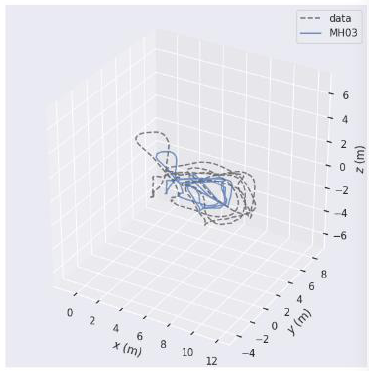
Figure 5. Trajectory of visual SLAM